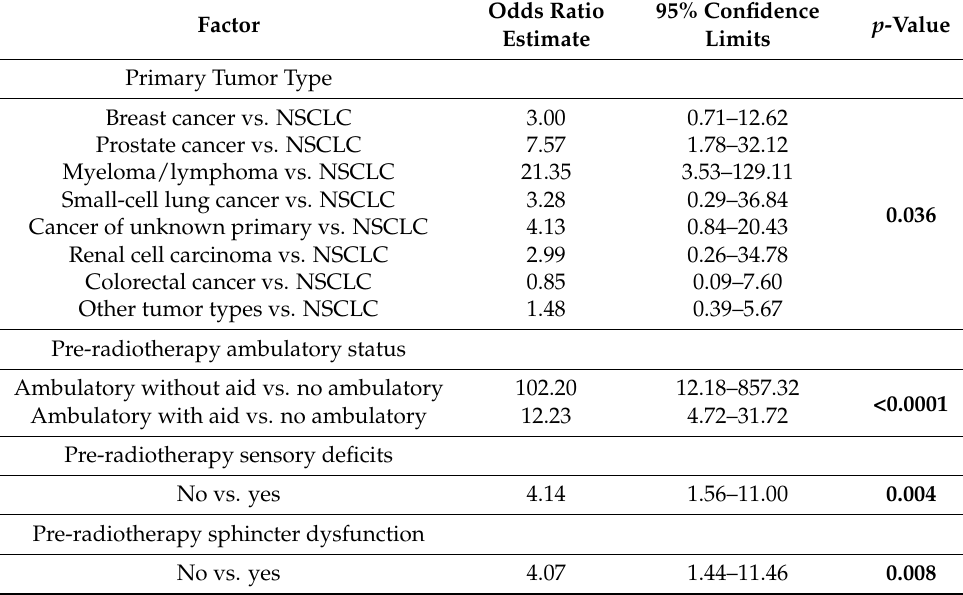
Table 2. Results of the multivariable analysis (odds ratio estimates and Wald confidence intervals) regarding associations with post-radiotherapy ambulatory status after applying a logistic regression model with backward stepwise variable selection (parsimonious